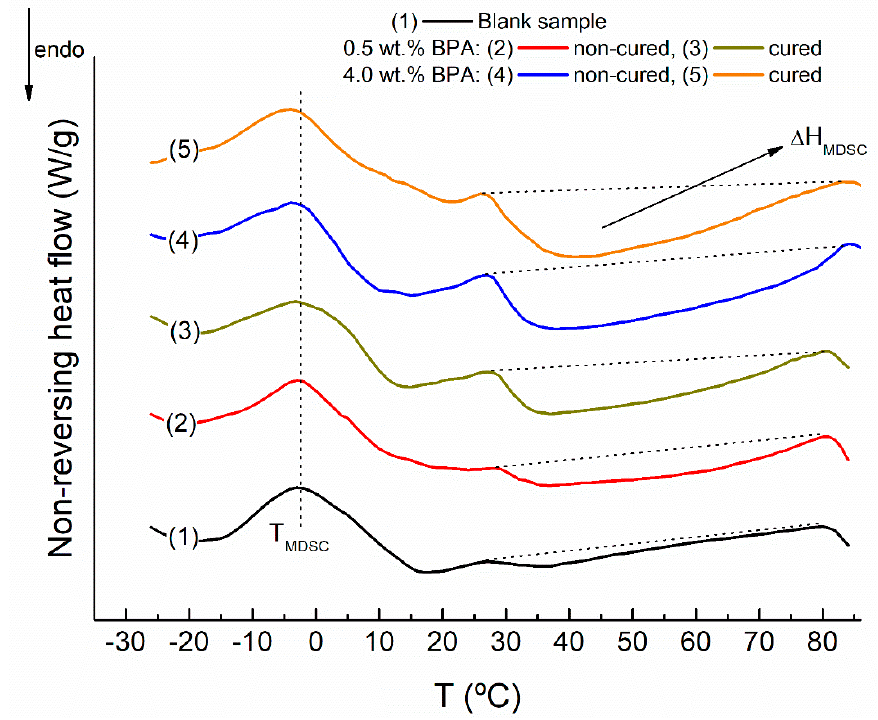
Figure 8. Nonreversing heat flow curves, from modulated calorimetry (MDSC) tests, for selected epoxy-modified binders and blank sample. Table 2. Energy associated with the endothermic fourth event, ∆ H MDSC , and characteristic temperature of the second event (T MDSC ) obtained by MDSC for selected